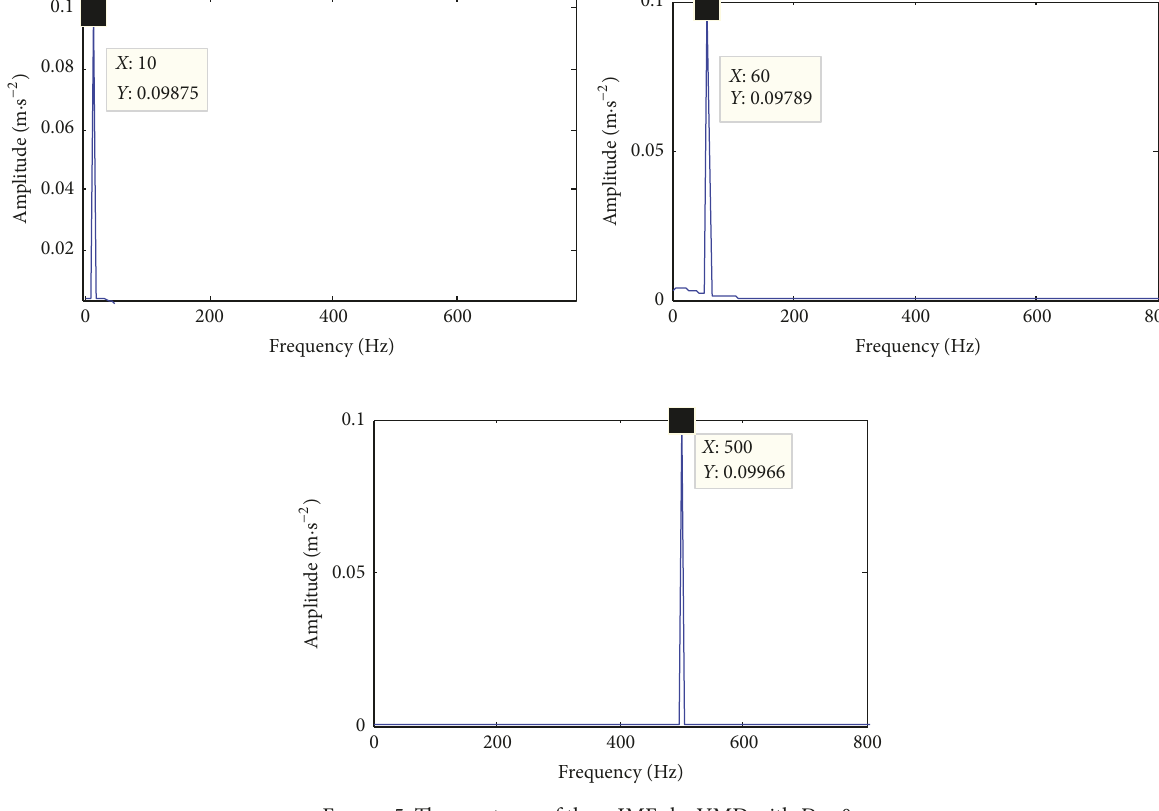
Figure 5: The spectrum of three IMFs by VMD with 𝐷 = 0 .